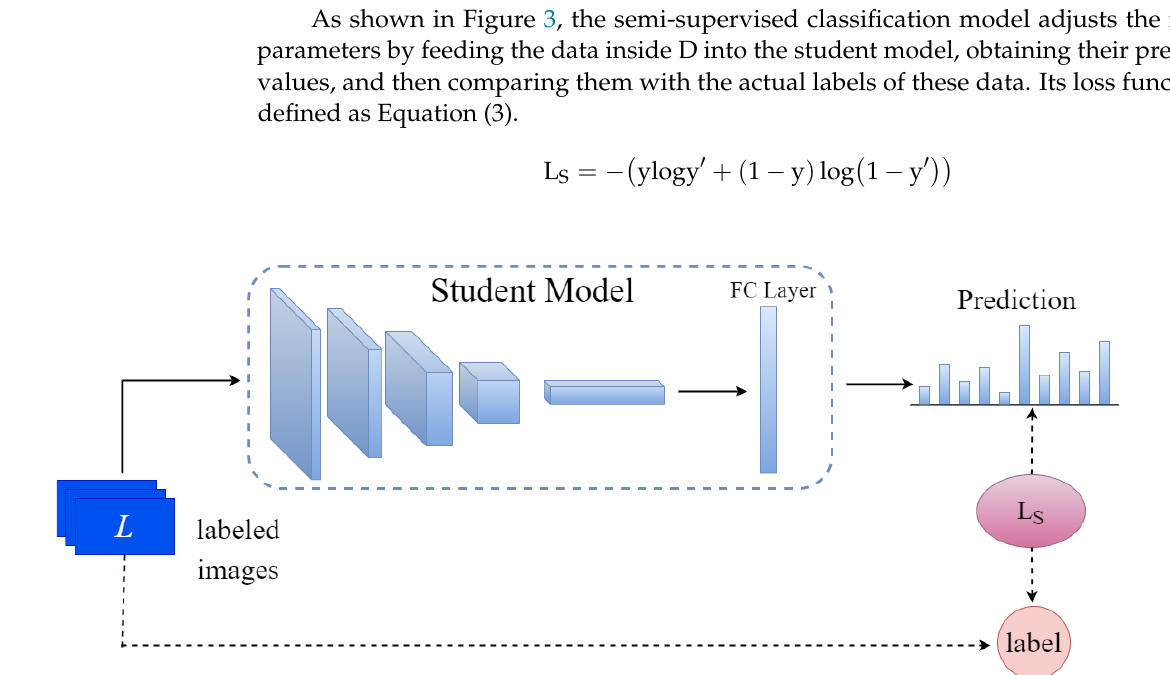
Figure 3. Fully supervised framework in the semi-supervised model .